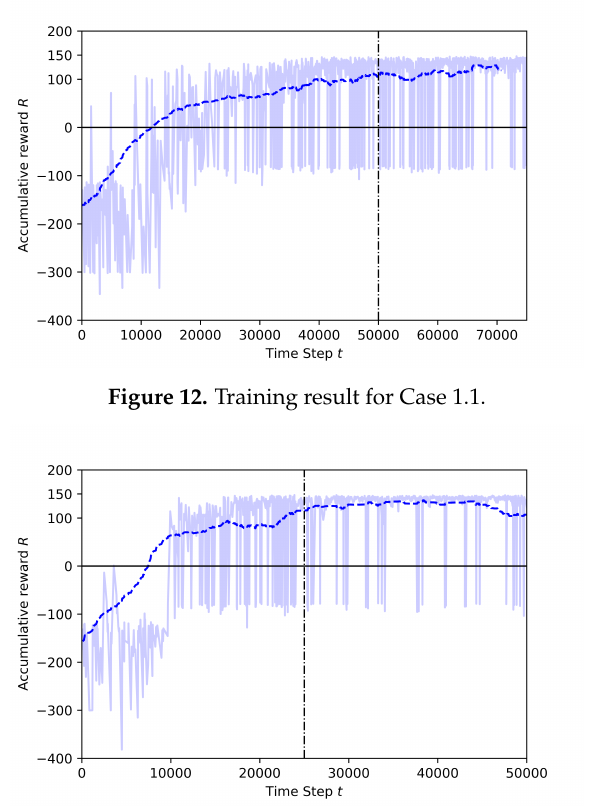
Figure 13. Training result for Case 1.2 by Transfer Learning.